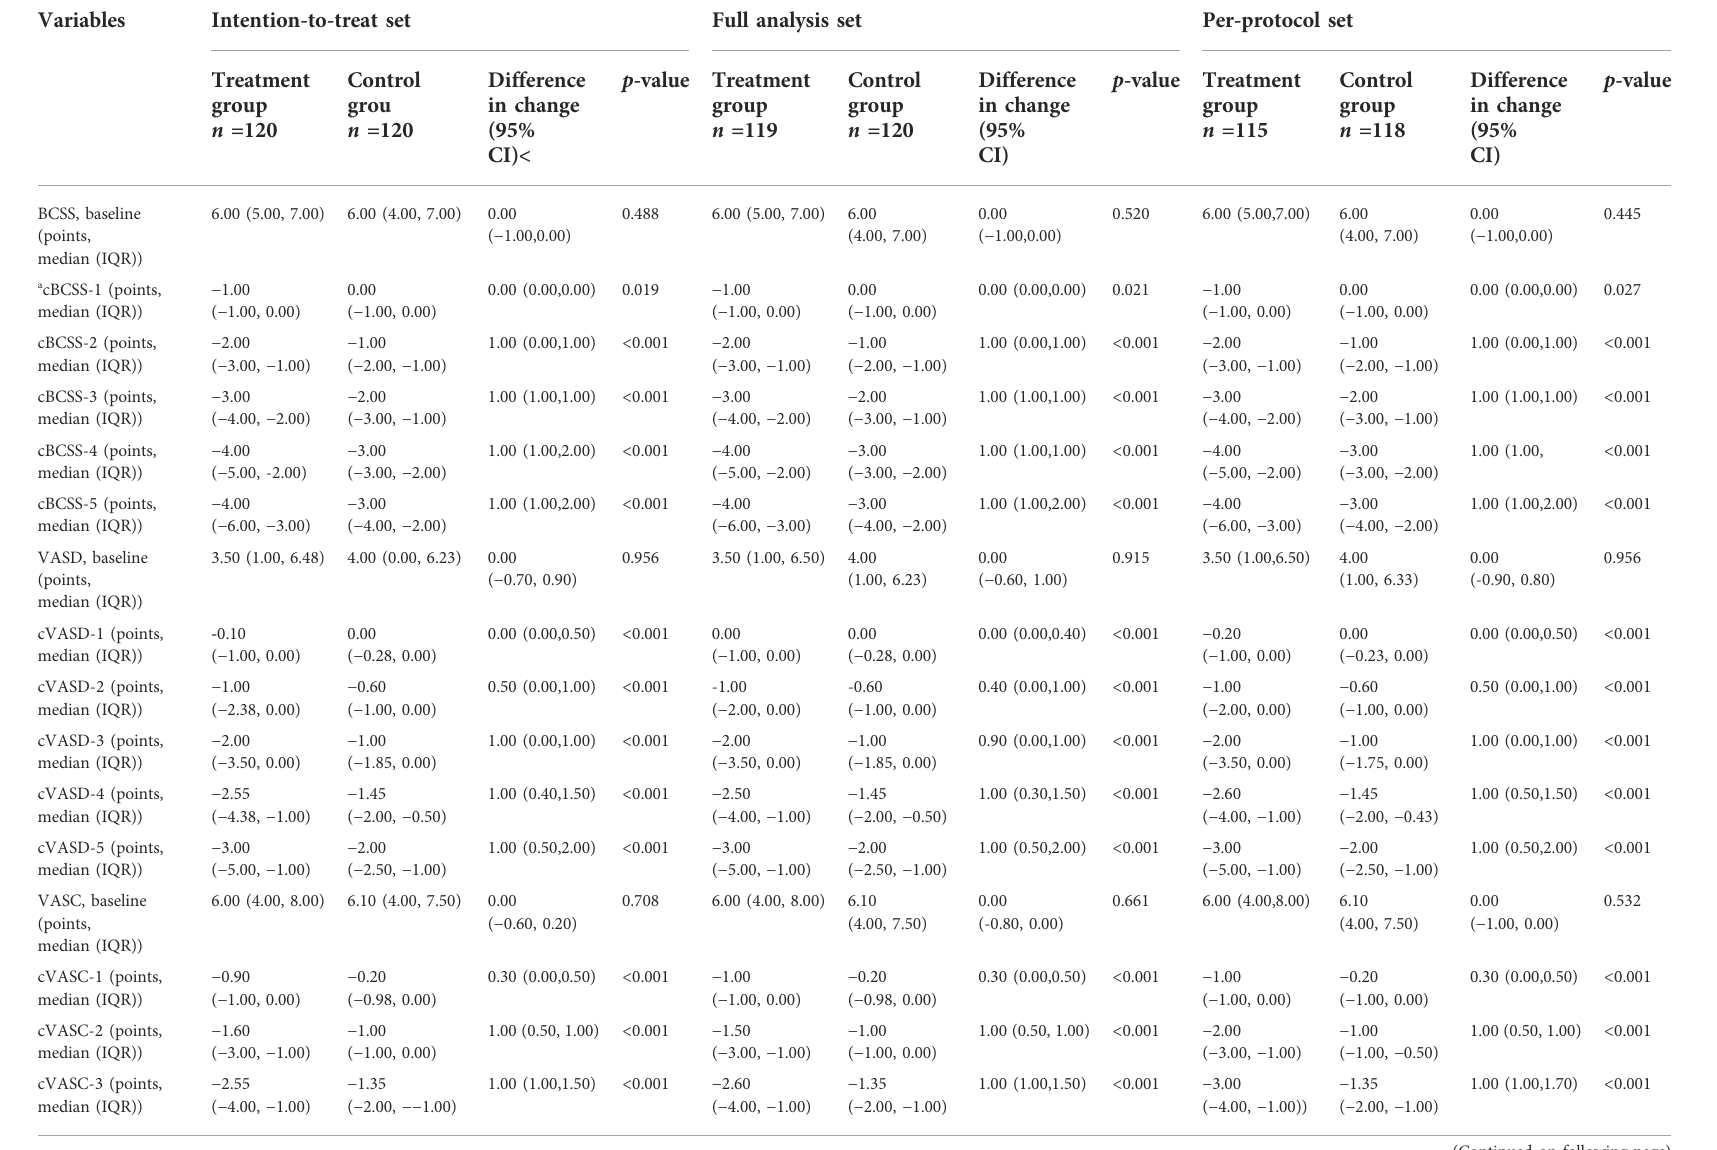
TABLE 2 Comparison of the primary and secondary